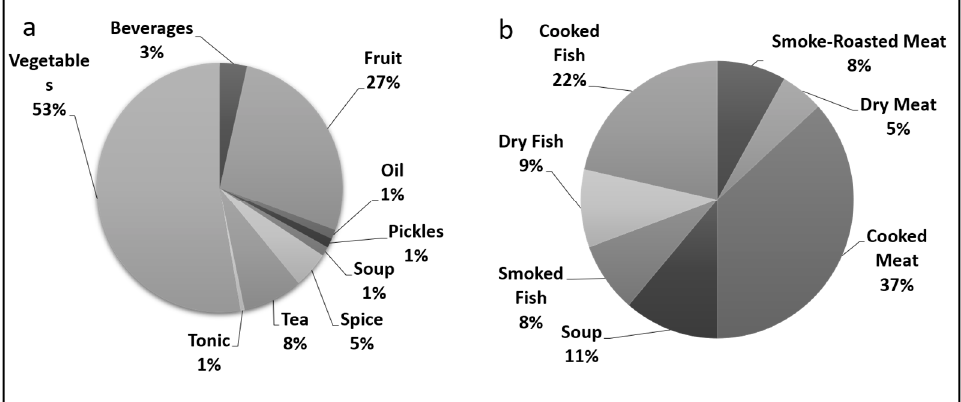
Figure 5. Consumption percentage of food preparation ( a ) plants ( b ) animals, birds and fish in the erstwhile state of J&K.